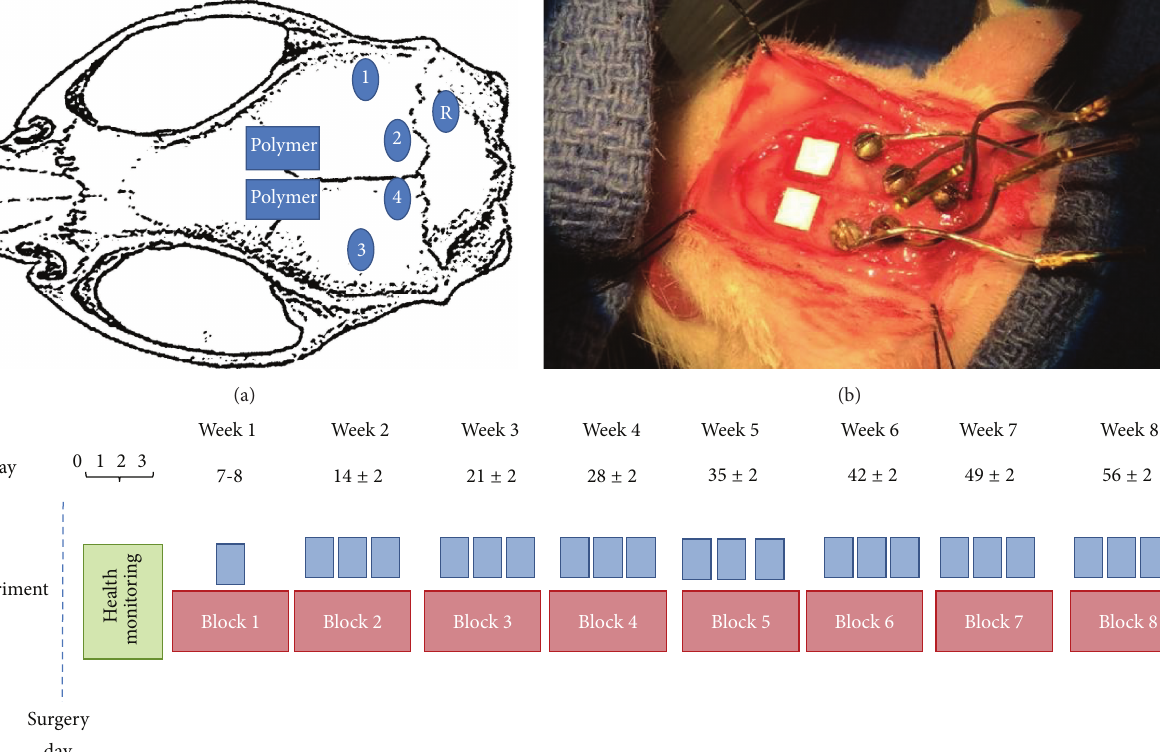
a day. Those observations were given scores (Table 1).